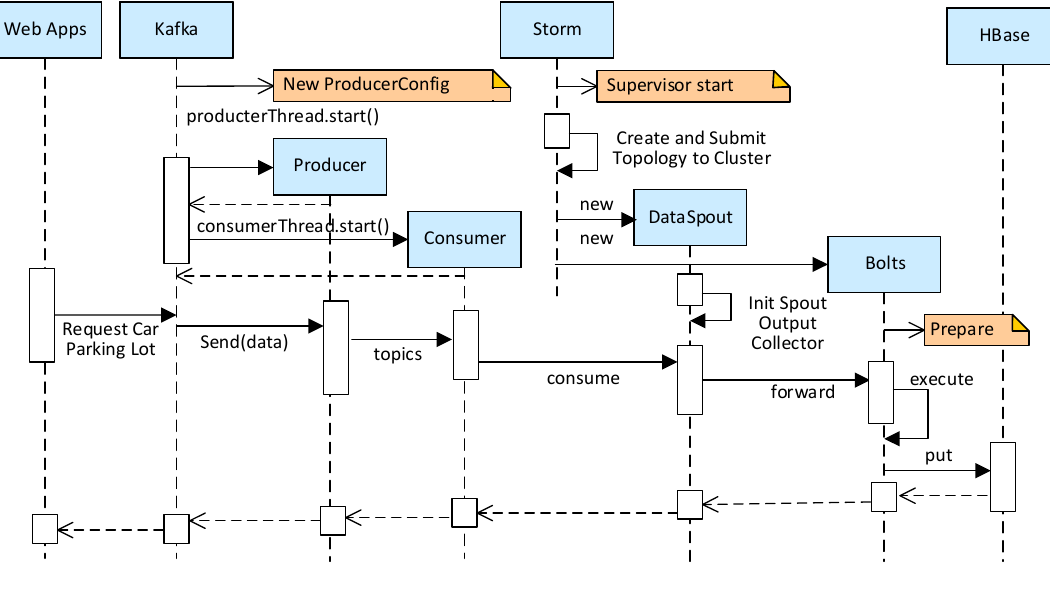
Figure 10. The sequence diagram of the web applications posting datasets to the cloud. Web Apps